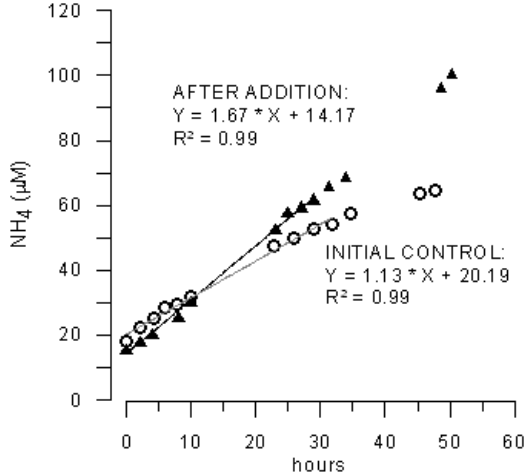
Figure 2. Ammonium concentration before (open dots, calculated initial control flux 4.18 mmol m − 2 day − 1 , n = 10) and after Marenzelleria neglecta addition (shaded triangles, calculated flux after addition 6.28 mmol m − 2 day − 1 , n = 9) in experiment 2 (run 1).